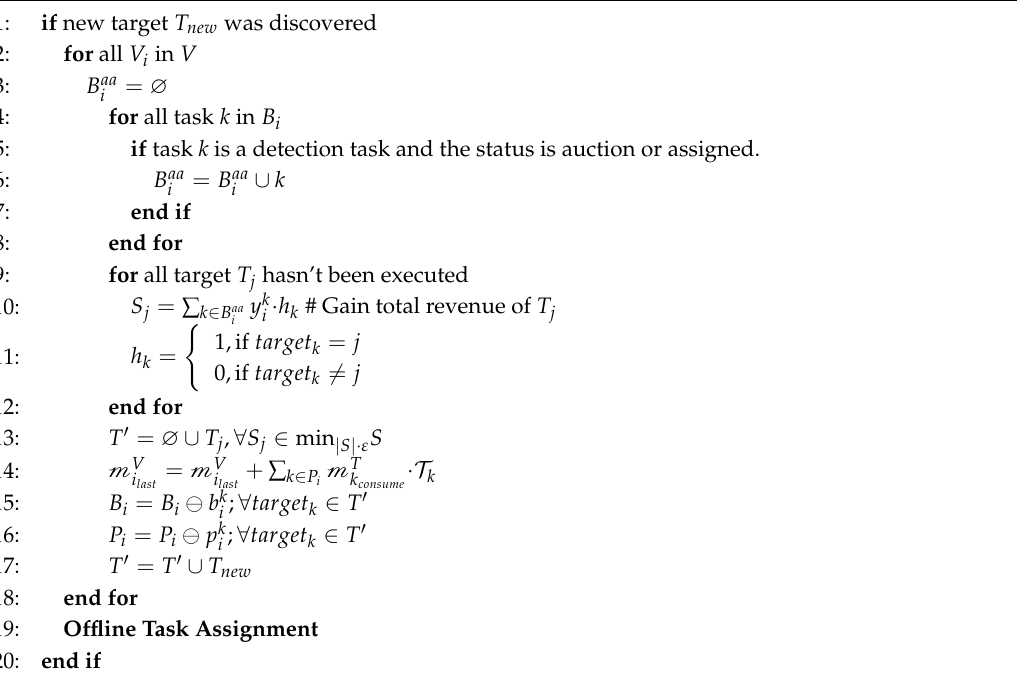
Algorithm 4 . Dynamic Task